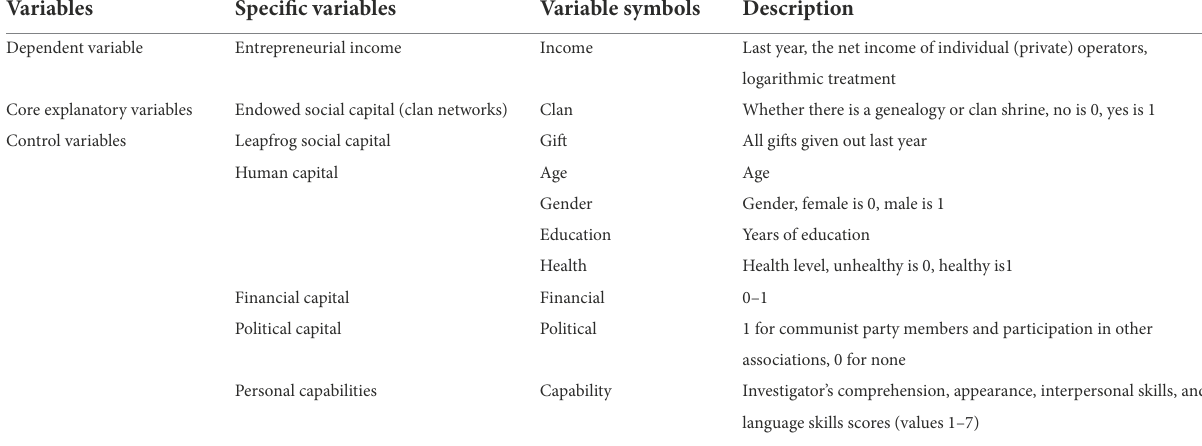
TABLE 1 Analysis of